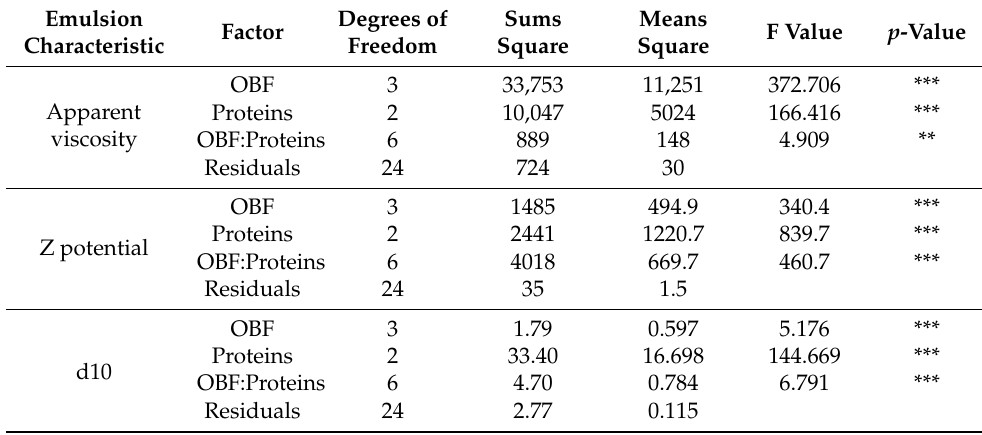
Table 3. Results of the 2-way ANOVA, taking OBF and protein content as